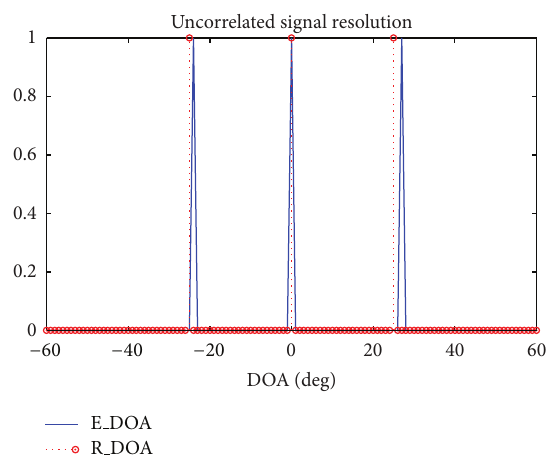
Figure 10: Uncorrelated signal resolution simulation based SVD- SR.